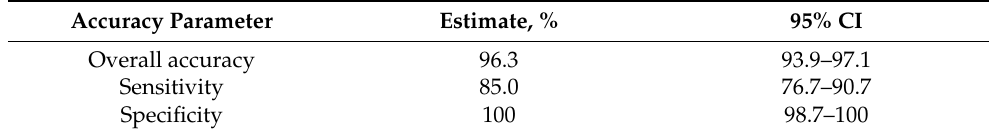
Table 1. Diagnostic accuracy parameters of the ND lateral flow test.